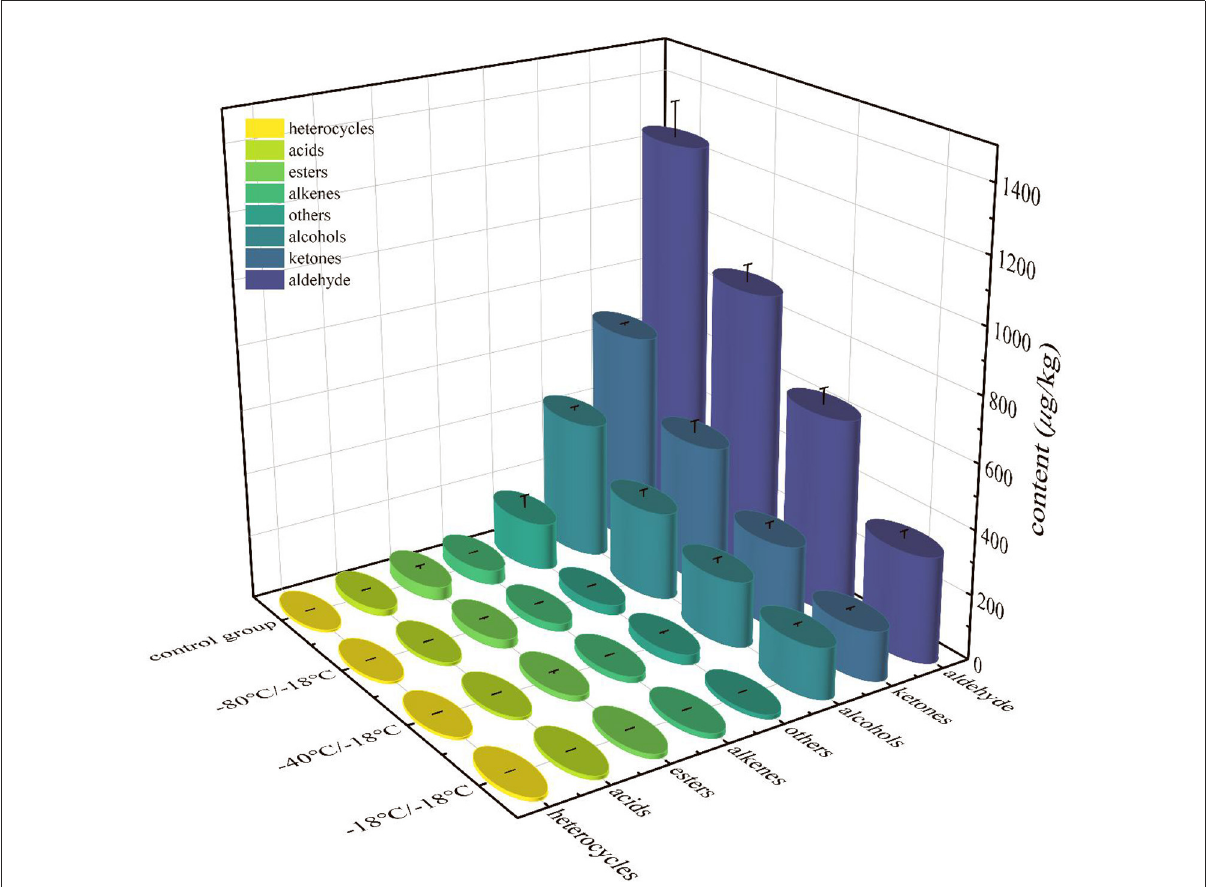
FIGURE5 Total contents of various volatile flavor substances of HGM with different freezing